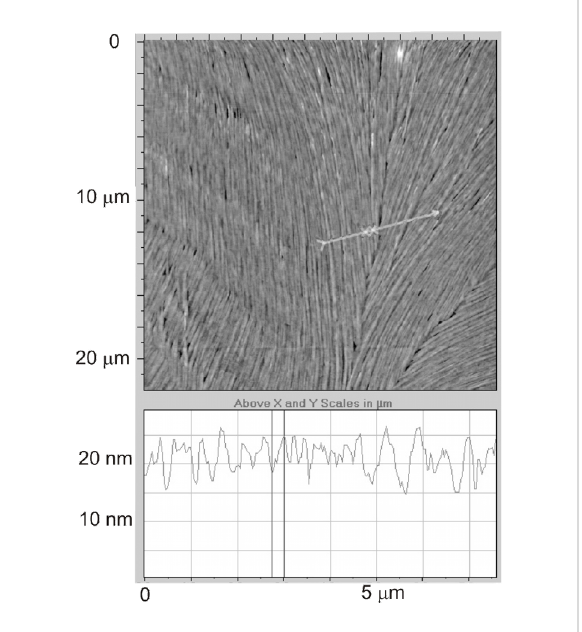
Figure 7: AFM image of the sample prepared from a concentration of 3 mg/ml.